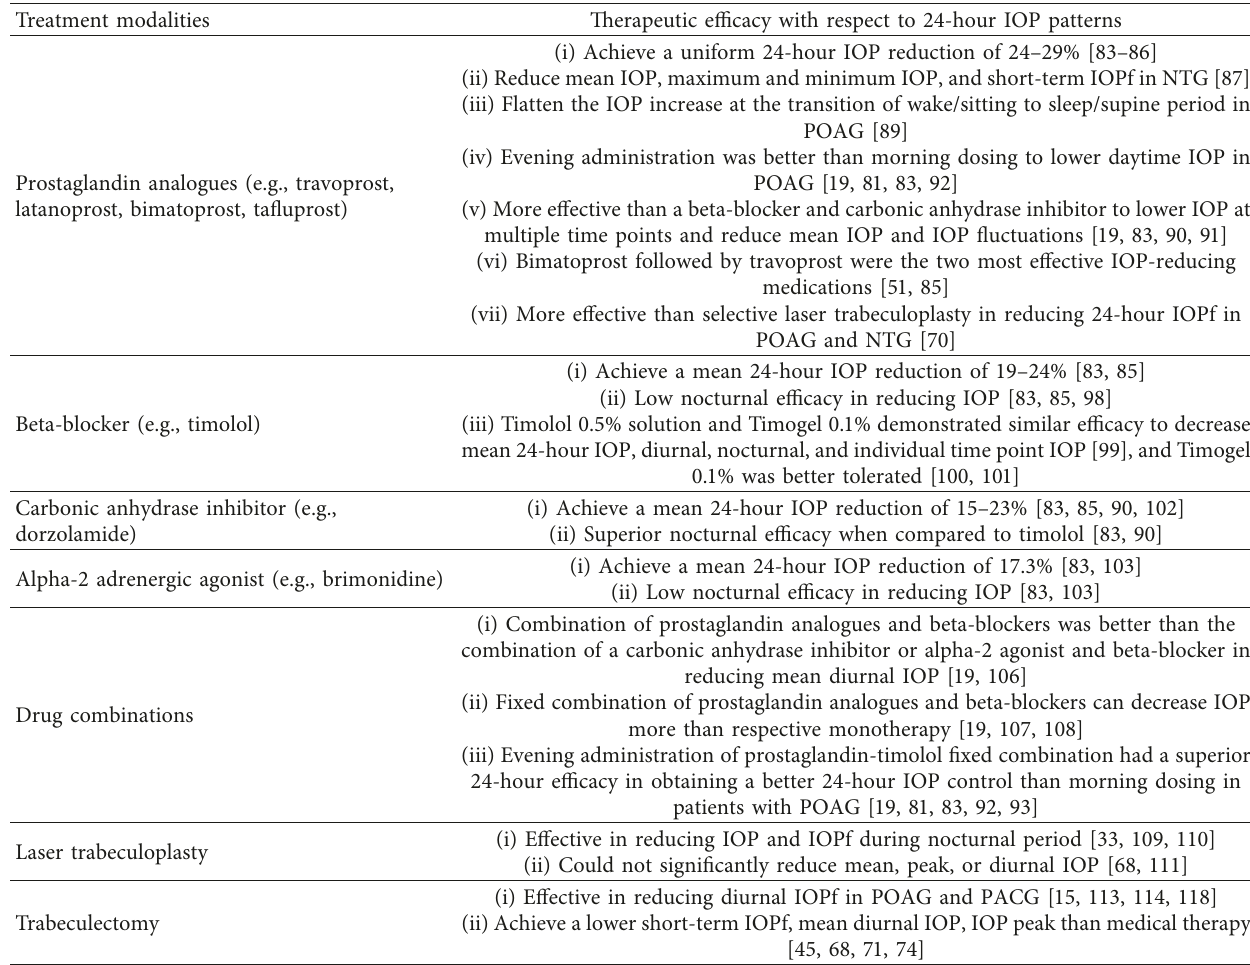
Table 2: Summary of therapeutic efficacy of current glaucoma management modalities with respect to 24-hour IOP patterns. Treatment modalities Therapeutic efficacy with respect to 24-hour IOP patterns